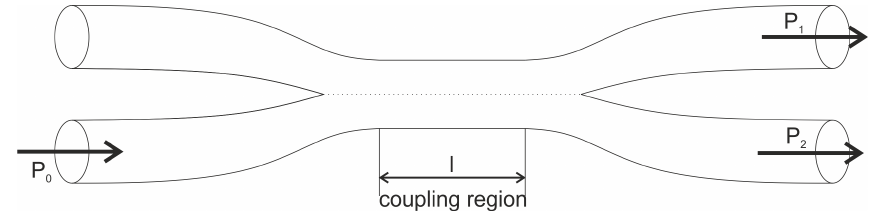
Figure 3. Schematic of fused tapered coupler (based on reference [34])